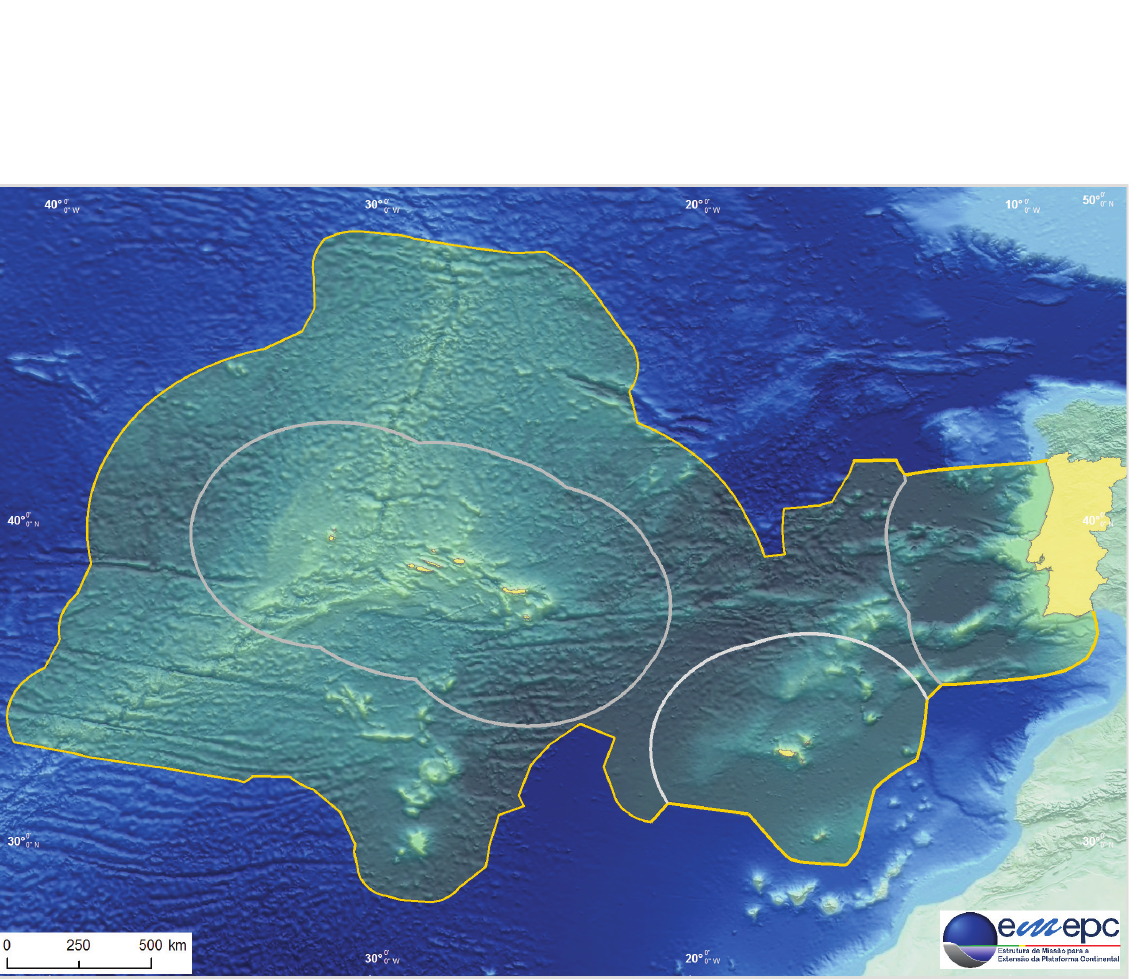
Fig. 1. Map of the study area, the Portuguese EEZ, that includes the territorial waters and the area proposed for the extension of the Portuguese continental shelf (source: EMEPC–Mission Structure for the Extension of the Continental